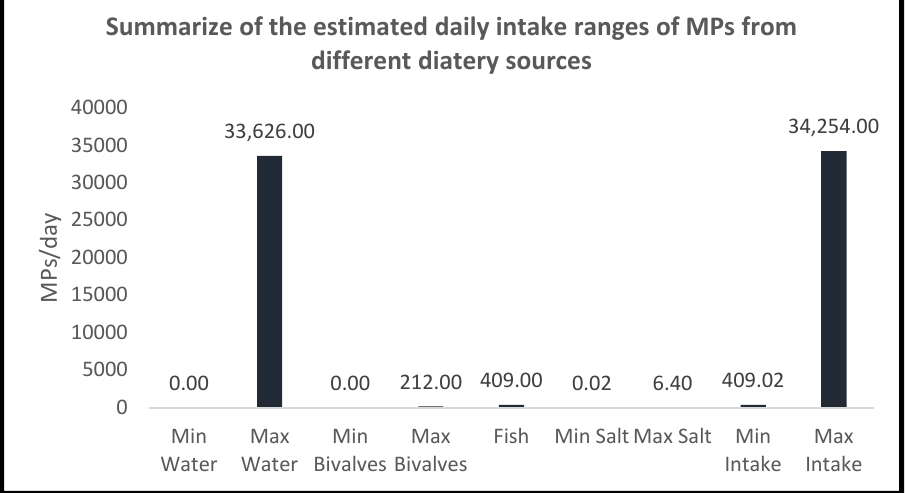
Figure 2. Summary of the MPs dietary intake ranges from each studied group.